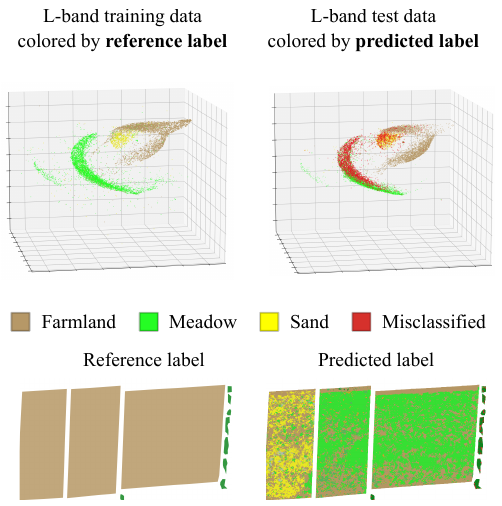
Figure 5. L-band data set: Missclassification of data points with reference label farmland .